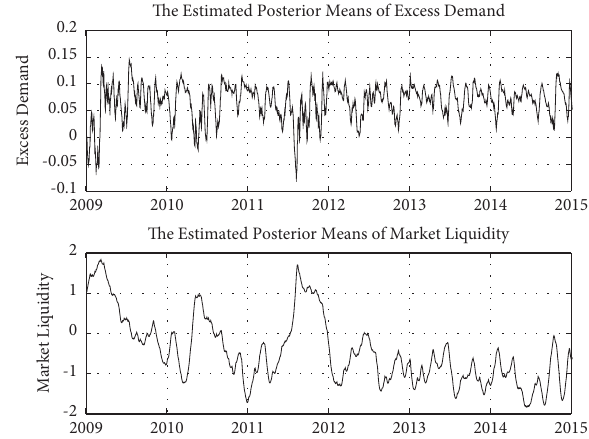
Figure 6: The evolution of the estimated posterior means σ